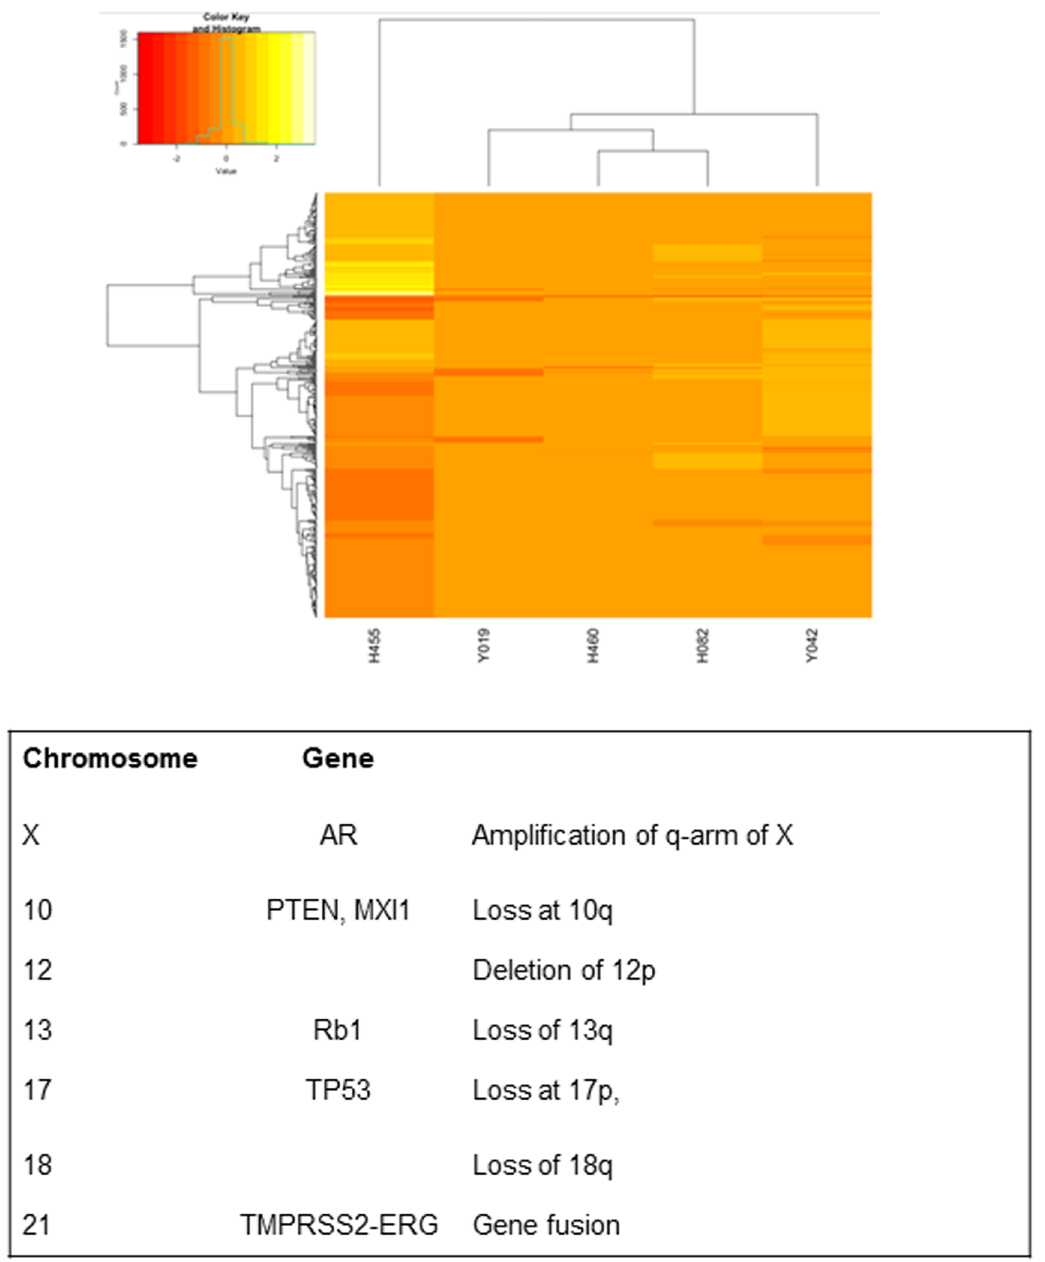
Fig 3. Unsupervised hierarchical clustering of copy number segmentation profiles. PDX, H455 is as an outlier and the most aberrantin terms of copy number. Table listing CNVs found in PDX H455. evaluated the xenografts for the presence of EBV DNA. We interrogated the sequences gener- ated from exome sequencing and compared xenografts to donor lymphocytes (Fig 4A). The total reads mapped to EBV were significantly higher in five of six xenografts compared to their matched donor lymphocytes which we calculated as equivalent to 1–2 copies of the EBV genome. In a larger series, we determined the presence of latent EBV infection by qPCR for EBV nuclear antigen (EBNA); which is found in all EBV-related malignancies and is critical